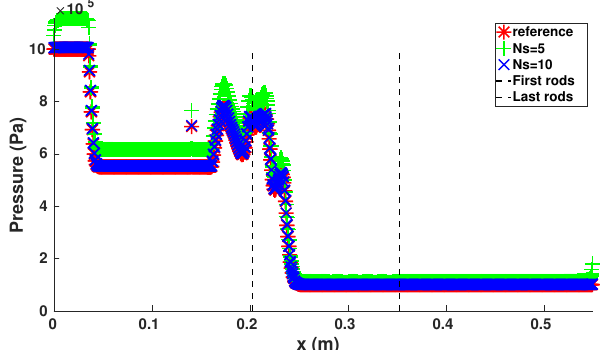
(cid:2) (cid:3) 10 − 4 , 10 − 3 - t = 8 × 10 − 5 s.